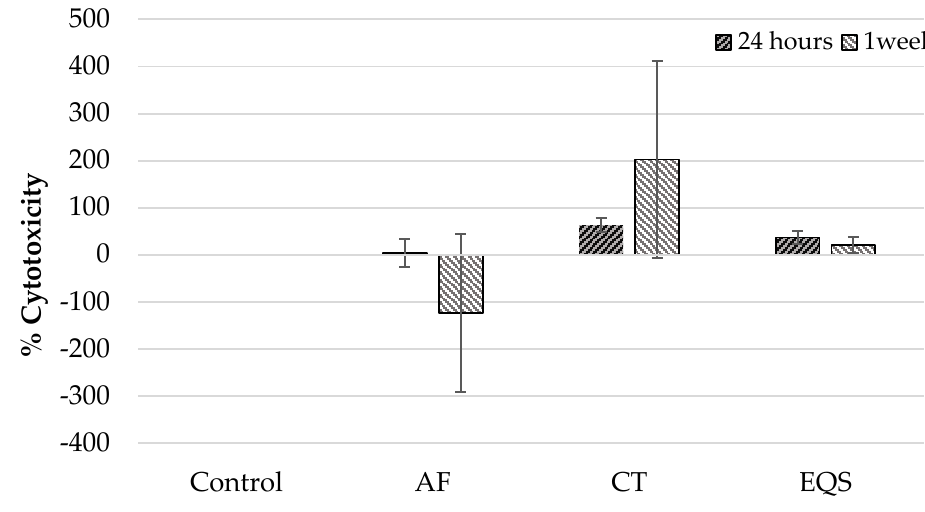
Figure 1. Cytotoxicity of CRs on hGF cells at 24 h and one-week time periods (mean ± SD). Table 4. Intragroup viability e ff ect of CRs on hGF and hPDLF cell lines at 24 h and one week time